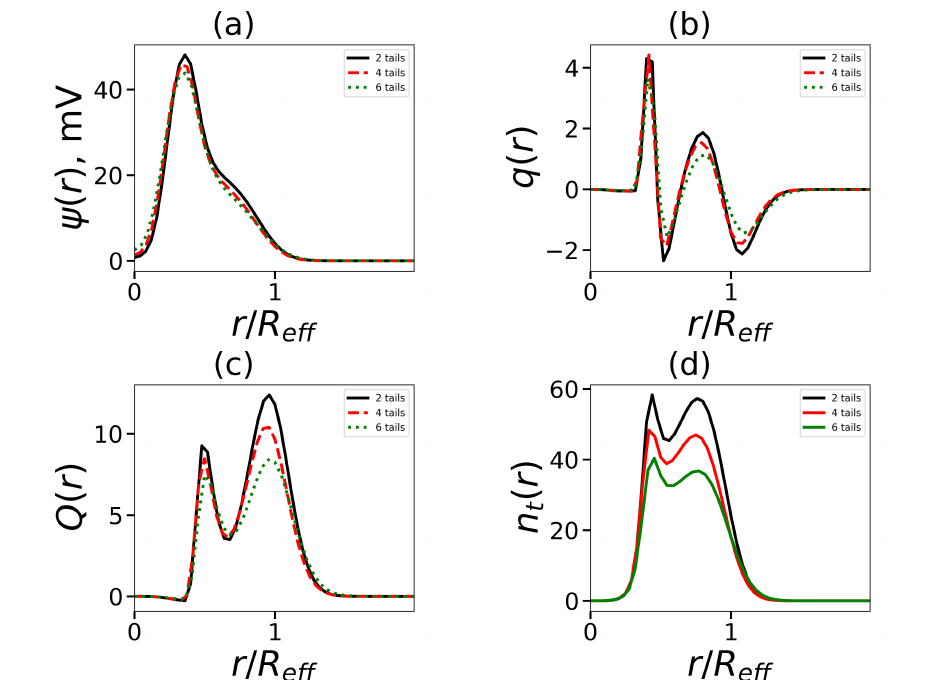
Figure 10. The normalized radial distribution (by effective radius R ef f ) ( a ) the electrostatic potential ψ , ( b ) the dimensionless charge q ( r ) , ( c ) the cumalative charge Q ( r ) and ( d ) the terminal charged groups of dendrons in the micelle. All cases correspond to the same overall number of hydrophobic segments in the surfactant N t · t = 120 ( t = 2, N t = 60; t = 4, N t = 30; t = 6, N t = 20) and generation number G = 4.